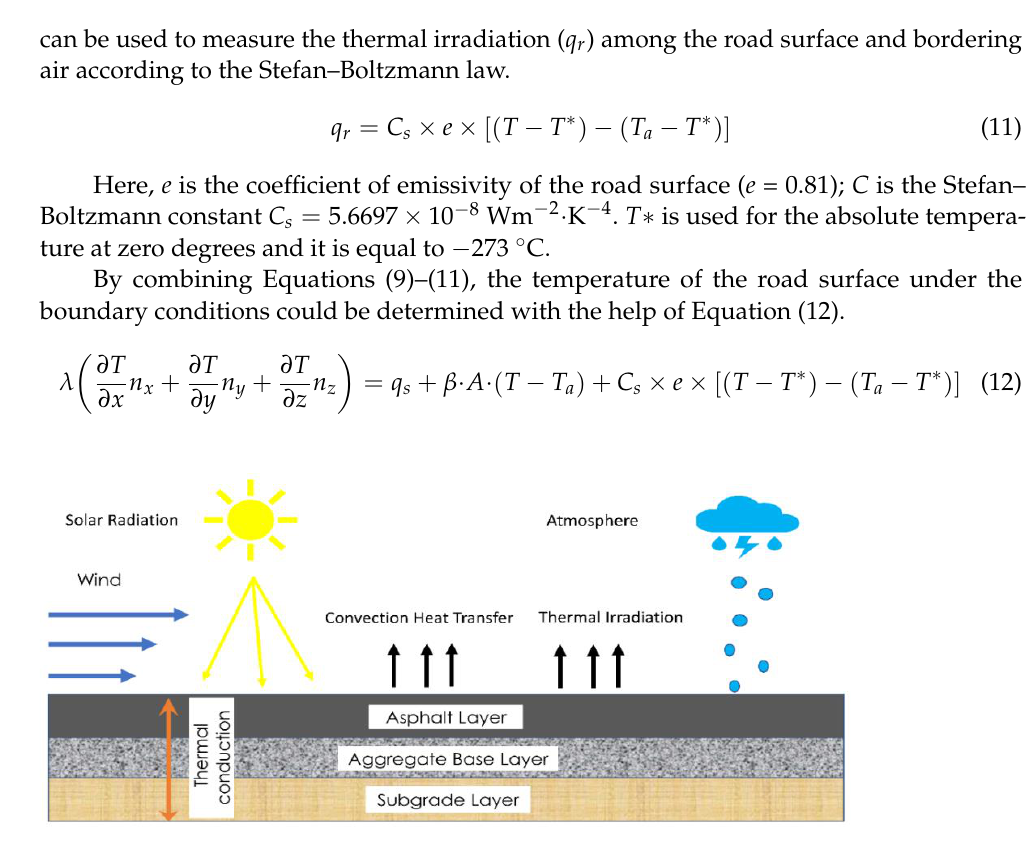
Figure 17. Effect of temperature variations on road surface due to climatic conditions.